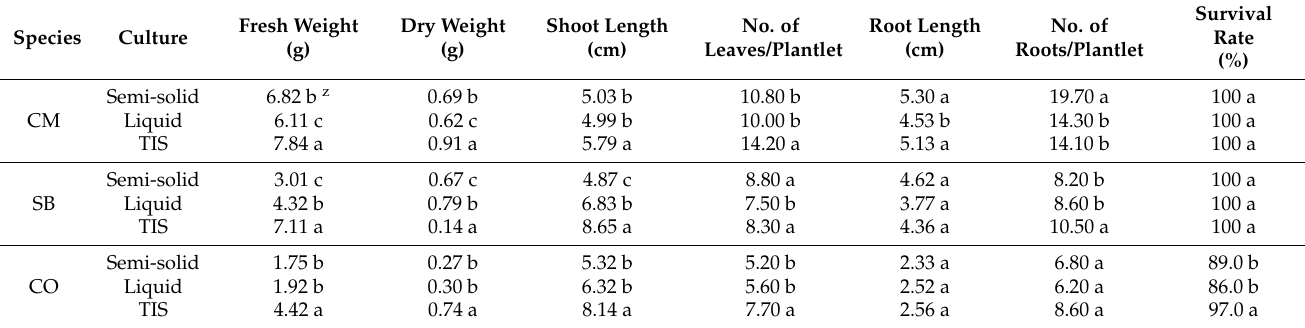
z Different letters indicate significant differences at p < 0.05 according to Duncan’s multiple range